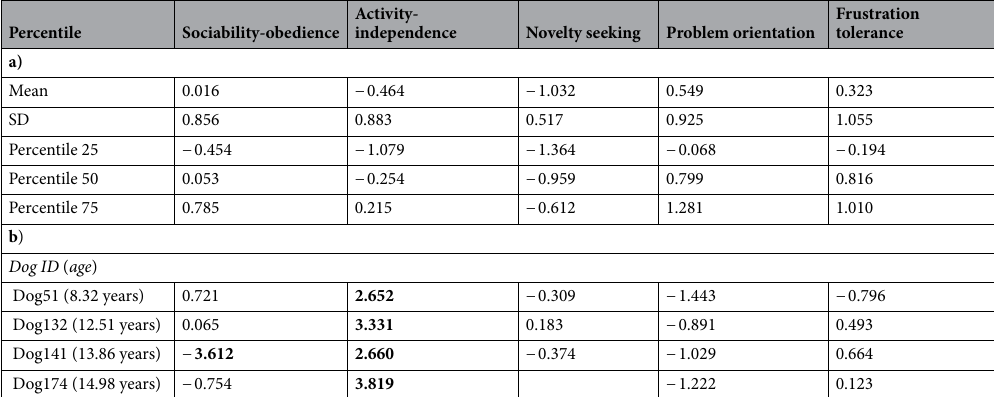
Table 2. ( a ) Means, standard deviations and percentiles of the personality trait scores (z scores) of the aged dogs (> 8 years) without the four outliers (N = 36), and ( b ) the individual scores of the four outlier dogs (extreme values are in boldface). In Novelty seeking one outlier dog had a missing value because the owner did not wish to participate in the Novel object test as he deemed it too stressful for his